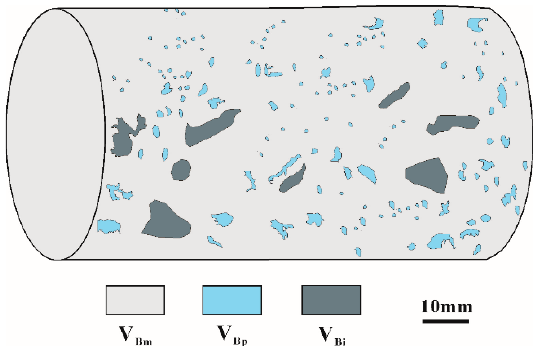
Figure 7. Schematic of volume introduction of each component of the sample.